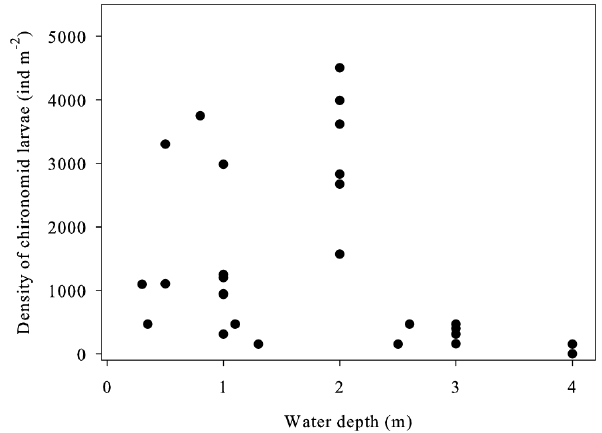
Fig. 1. Density of chironomid larvae as function of water depth in the littoral area of the ML-111 (June–July 2008). The sediment samples were collected following transects at 5 different character- istic areas of the